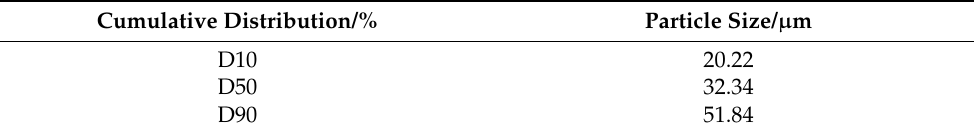
Table 1. The particle size distribution of powder.